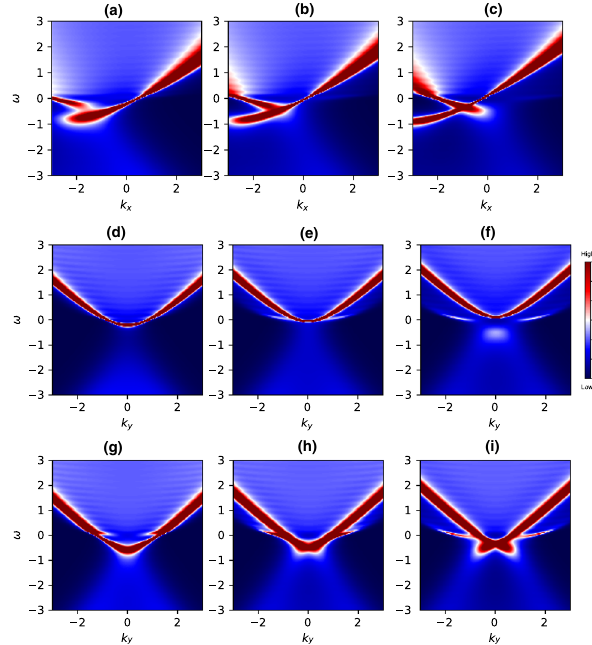
Fig. 2 Energy–momentum dispersion with p 1 , p 2 set to non-zero and m ψ = 0 , q = 1, T /μ = 0 . 009, m 2 φ = 0, k 1 /μ = 0 . 8,and k 2 /μ = 0. Top and middle panel are along ω − k x ( k y = 0 ) and ω − k y ( k x = 0 ) plane, while the bottom panel is along ω − k ( k = − 1 ) . From left to right the parameters [ ( p y x [ ( 0 . 3 , − 0 . 2 ),( 0 . 3 , − 0 . 3 ),( 0 . 3 , − 0 . 4 ) ]